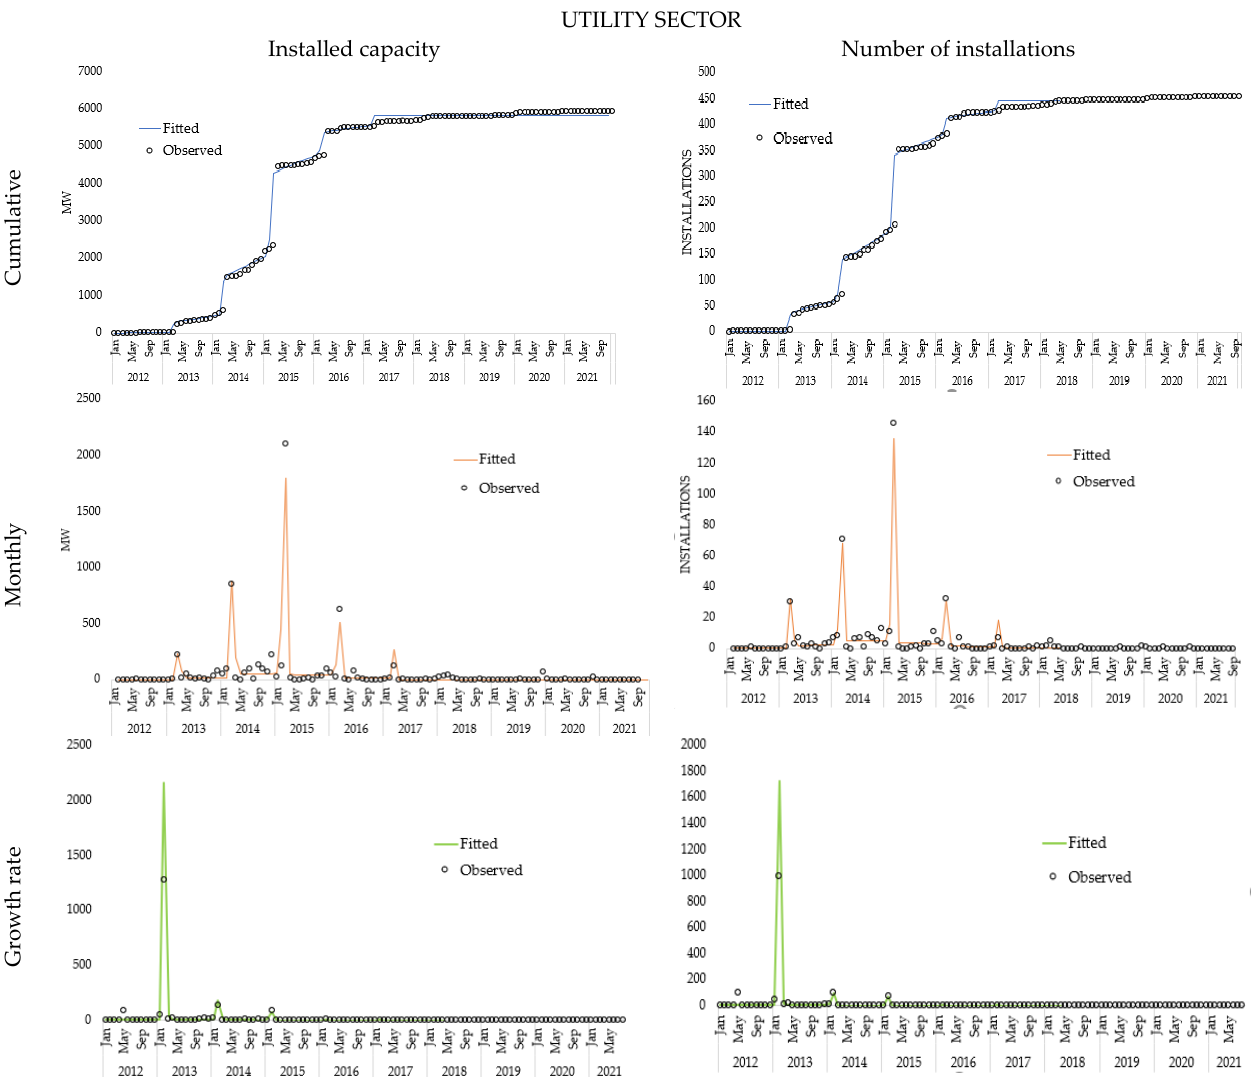
Figure 4. Observed vs. fitted (by the best GIM model) PV adoptions in the UK 2010 – 2021 for the utility sector by installed capacity and by numbers of installations. For each category considered, the figure reports: (i) cumulative adoptions, (ii) monthly adoptions, and (iii) growth rate of cumulative adoptions.